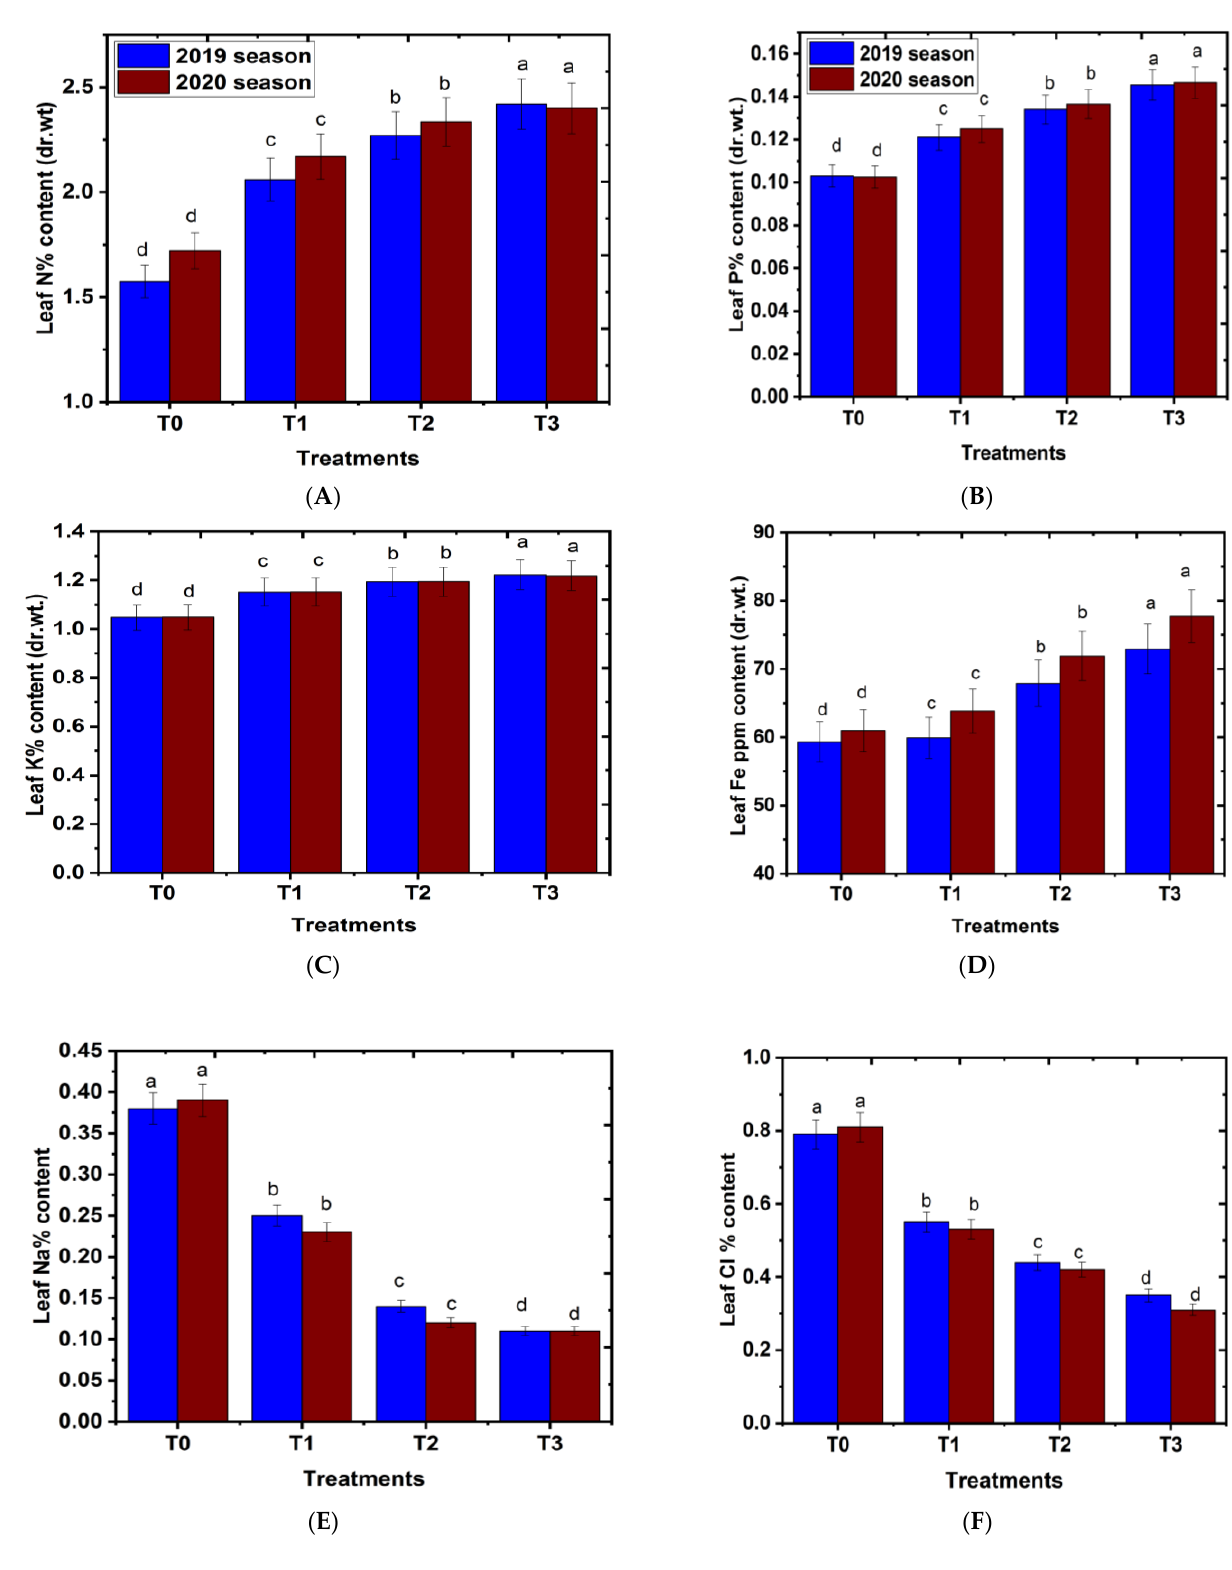
Figure 3. Effect of magnetic iron application on leaf nutrient content of ‘Chinese’ mandarin trees during 2019 and 2020 seasons. ( A ) Leaf N% content (dr.wt.), ( B ) leaf P% content (dr.wt.), ( C ) leaf K% content (dr.wt.), ( D ) leaf Fe ppm content (dr.wt.), ( E ) leaf Na content (%) and ( F ) leaf Cl content (%). T0: 0 g magnetic iron.tree −1 , T1: 250 g magnetic iron.tree −1 , T2: 500 g magnetic iron.tree −1 , and T3: 750 magnetic iron.tree −1 . Bars indicate mean values ± SE ( n = 9). Different letters above columns indicate significant differences among magnetic iron treatments at p = 0.05 according to Bartlett’s test.